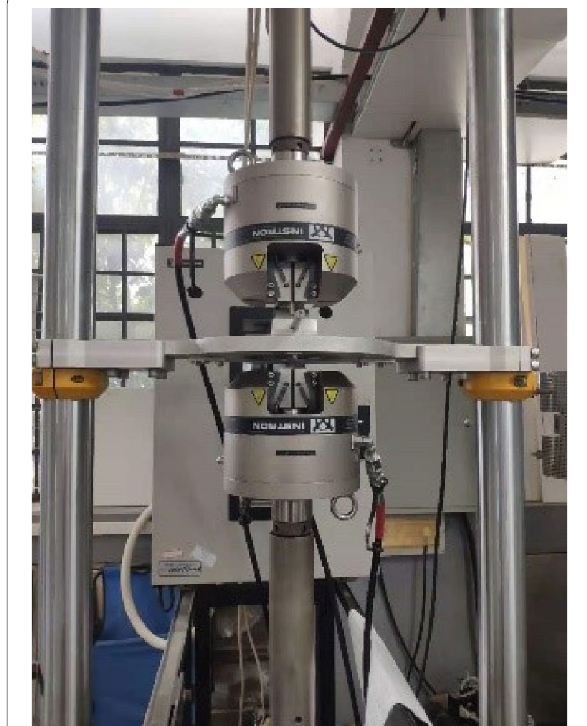
Figure 9 Three-dimensional non-contact optical profilometer Figure 10 Fretting fatigue experiment machine